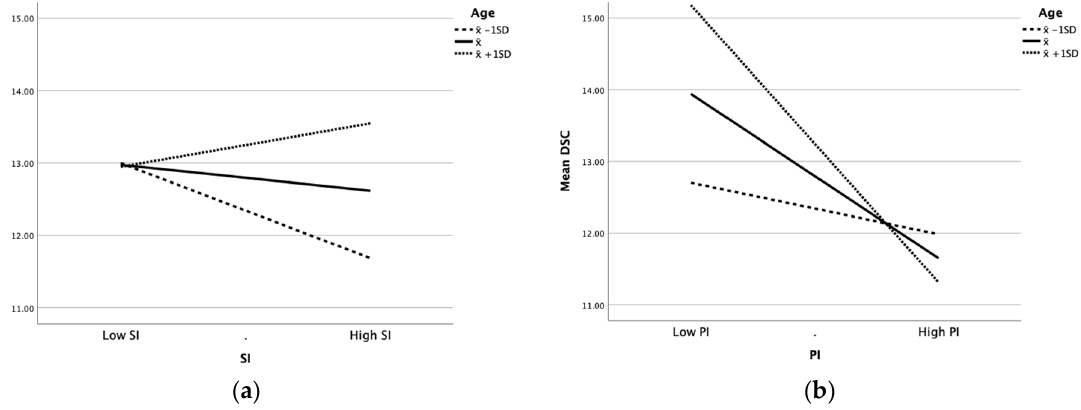
Figure 2. Moderating effect of age in the relationship between ( a ) social impact (SI) on dental self-confidence (DSC) and ( b ) psychological impact (PI) on DSC.